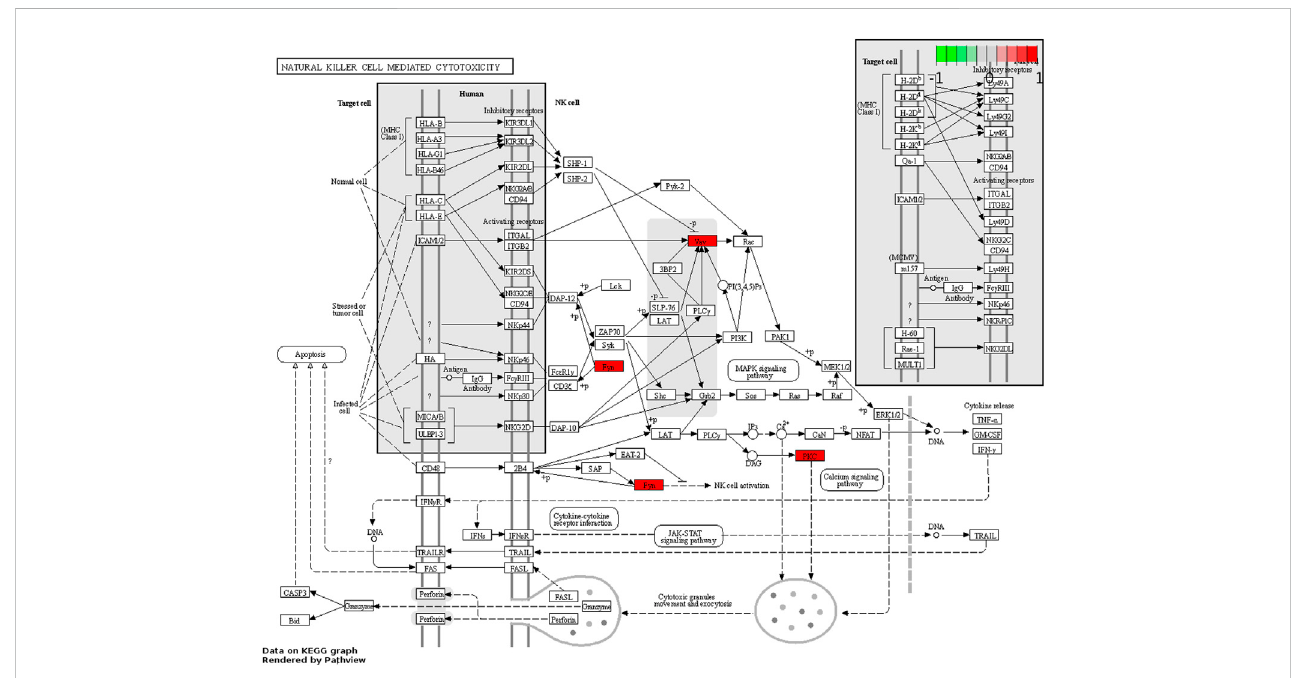
FIGURE 5 The map of natural killer (NK) cell mediated cytotoxicity signaling pathway. Red: up-regulation, grey: no signi fi cant